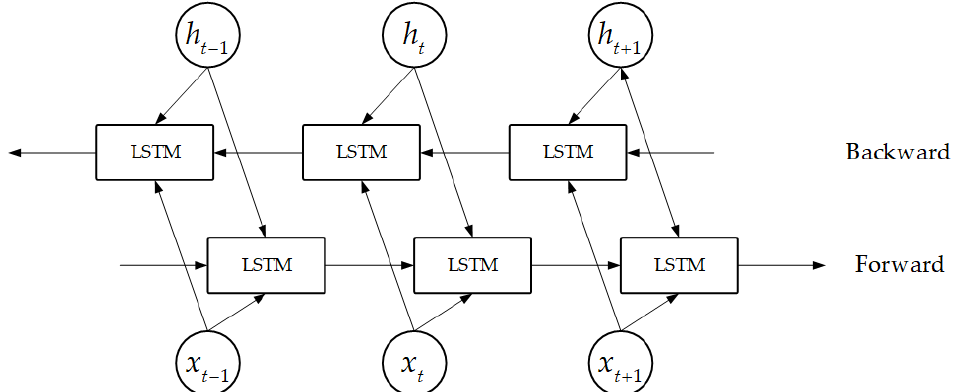
Figure 4. The structure of the BILSTM.